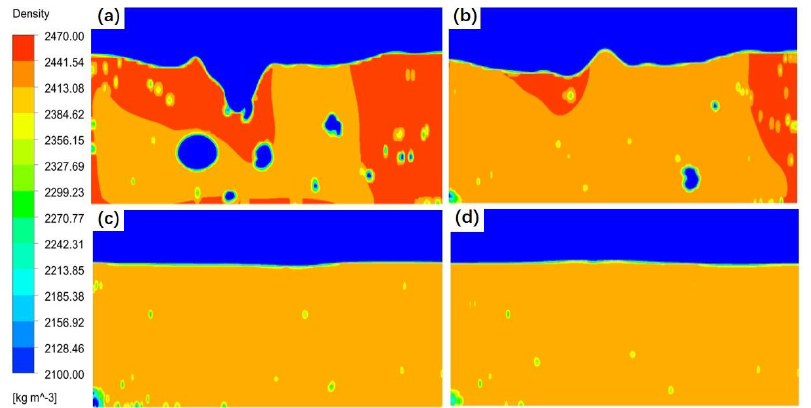
Figure 3. Density distribution fields along the longitudinal section of the mixture when stood for ( a ) 0 s, ( b ) 0.5 s, ( c ) 1.0 s and ( d ) 1.2 s. ( a ) 0 s, ( b ) 0.5 s, ( c ) 1.0 s and ( d ) 1.2